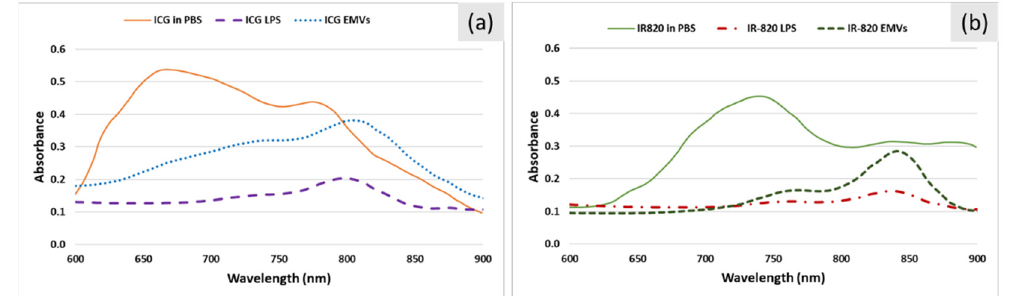
Figure 7. Characterization of purified ICG- and IR-820-loaded liposomes and EMVs. ( a ) Absorption spectra of ICG samples: ICG in PBS, ICG-loaded liposomes (LPS), and ICG-loaded EMVs. ( b ) Absorption spectra of IR-820 samples: IR-820 in PBS, IR-820-loaded liposomes (LPS), and IR-820-loaded EMVs. Liposomes and EMVs are dispersed in PBS